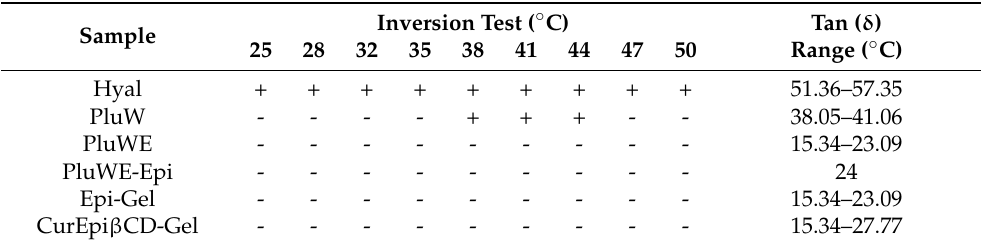
Table 3. Gelling temperatures obtained by inversion test and loss tangent (tan δ ) calculation. Samples are: Pluronic ® 17% w / v water solution (PluW), Pluronic 17% w / v water/ethanol solution (PluWE), PluWE containing Epi β CD (Plu-Epi), optimized gel containing only Epi β CD (Epi-Gel) and optimized gel loaded with CurEpi β CD GR binary system (CurEpi β CD-Gel). Inversion test was considered positive when gel remained at the bottom of the tube for 30 s after